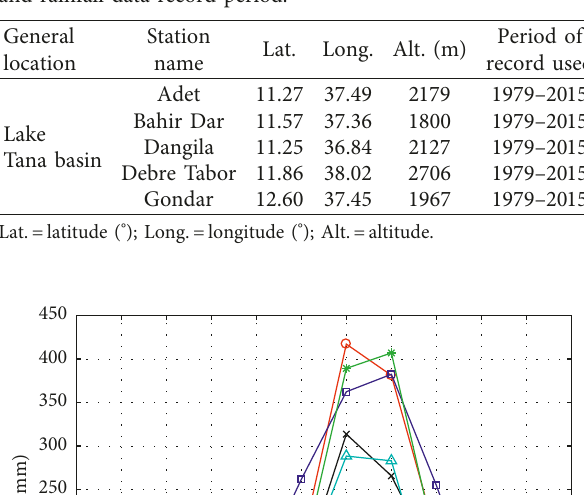
Table 2: Descriptive statistics of the annual rainfall for each